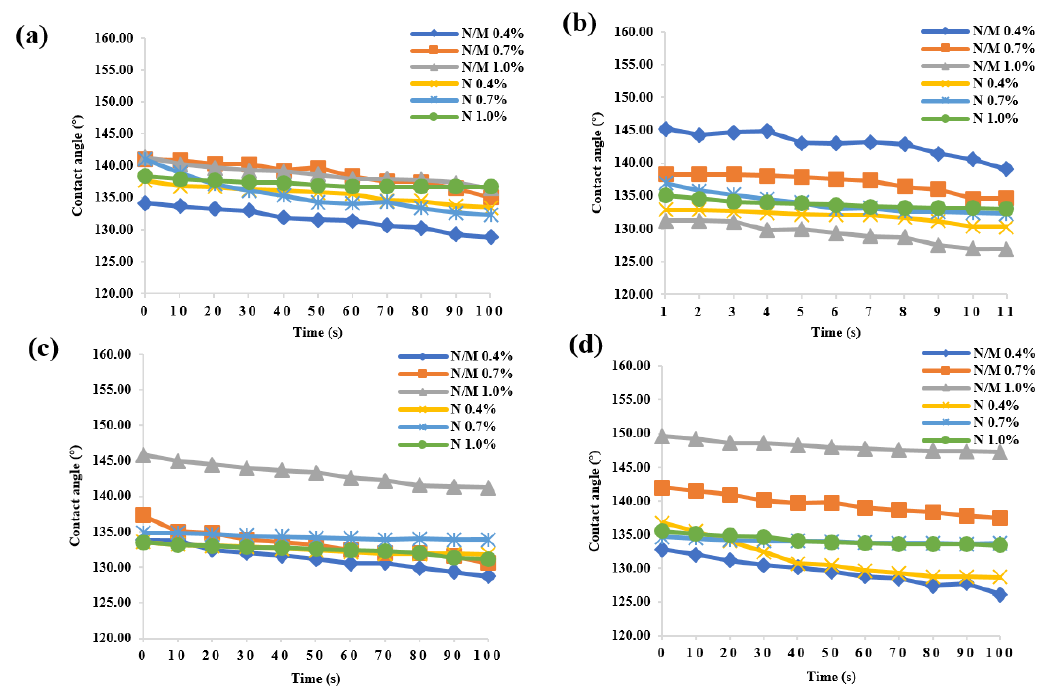
Figure 5. The water contact angles of wood samples with different treatment conditions. ( a ) Spraying layers 5 times, ( b ) spraying layers 10 times, ( c ) spraying layers 15 times and ( d ) spraying layers 20 times.